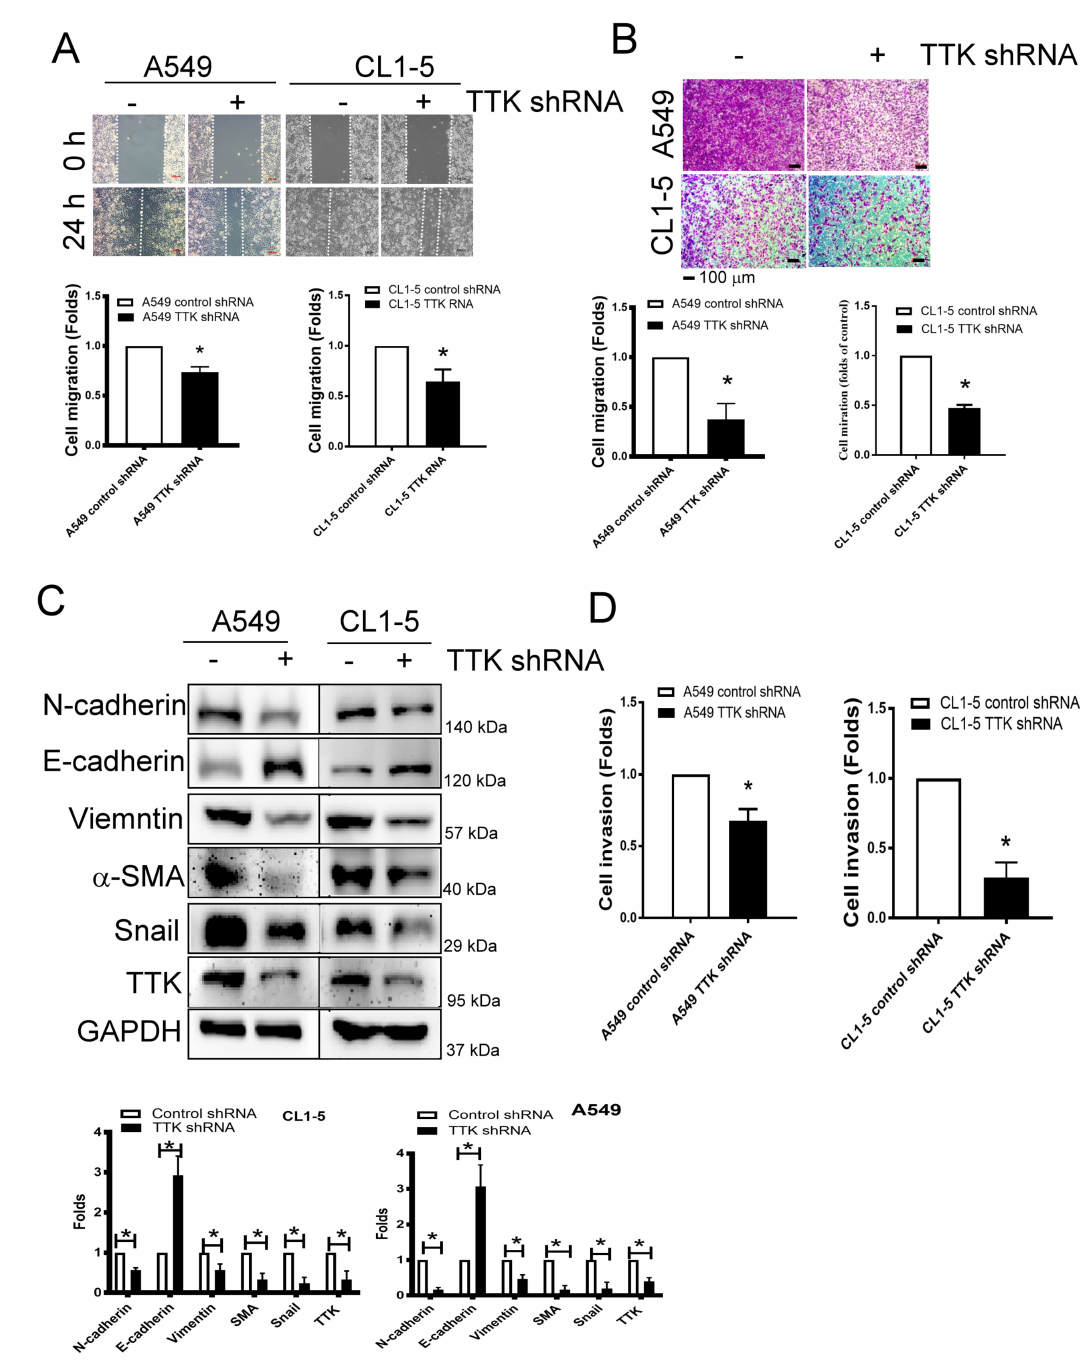
Figure 3. Inhibition of TTK decreases cancer migration and epithelial–mesenchymal transition (EMT). Inhibition of TTK decreased cell migration, as determined by wound healing ( A ) and the transwell system ( B ). Decrease TTK reduced EMT ( C ) and invasion ( D ). Control shRNA or TTK shRNA plasmid transfected A549 and CL1-5 cells were seeded in the upper insert coated with (for invasion analysis) or without (for migration analysis) Matrigel in serum-free conditions and culture medium (10% FBS) was added into the lower well to act as a chemo-attractant for 24 h (for migration) or 48 h (for invasion). The migratory and invasive cells were quantified by crystal violet or fluorescence dye staining. EMT marker expressions were assessed by an Immunoblot. All experiments were performed independently at least three times. * Significant di ff erence between the control and TTK knockdown cells ( p <